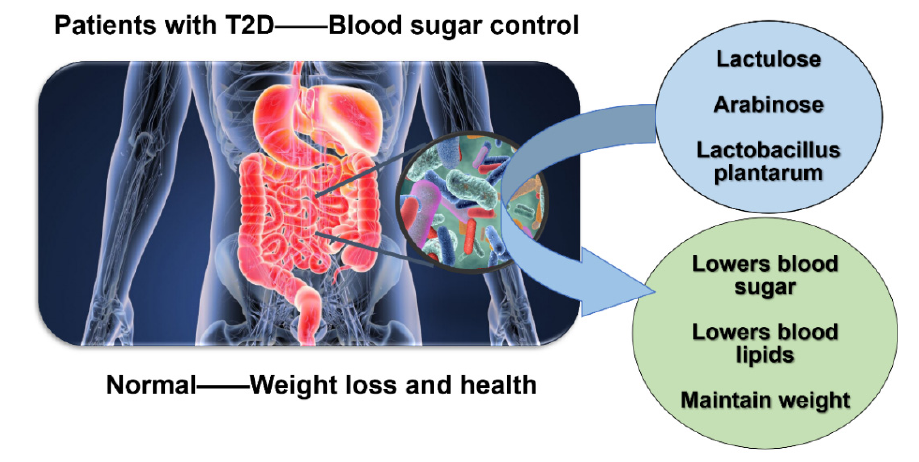
Figure 2. Function of the new combination of probiotics.